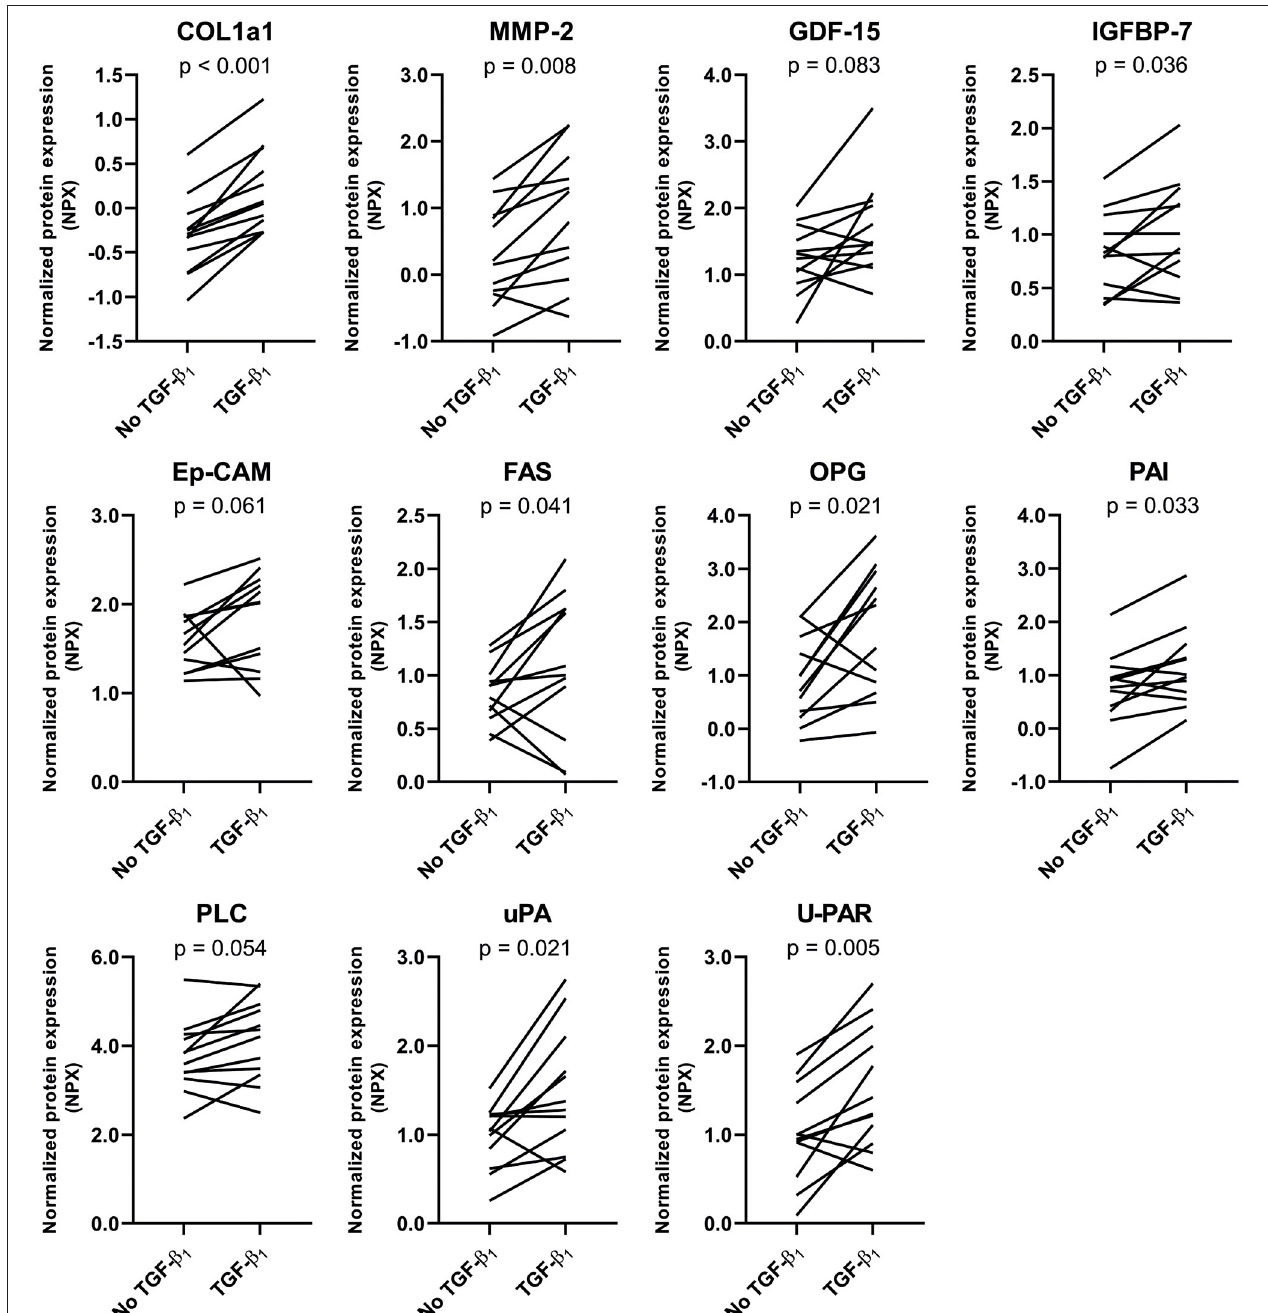
FIGURE 3 | Targeted proteomics confirms the TGF- β 1-induced fibrotic response in tissue-engineered cardiac constructs. TGF- β 1 stimulation results in an increased expression of several fibrosis-related proteins. Data are represented as mean normalized protein expression (compared to internal control) per experiment ( n = 12). Statistical analysis was performed using paired two-tailed Student’s t